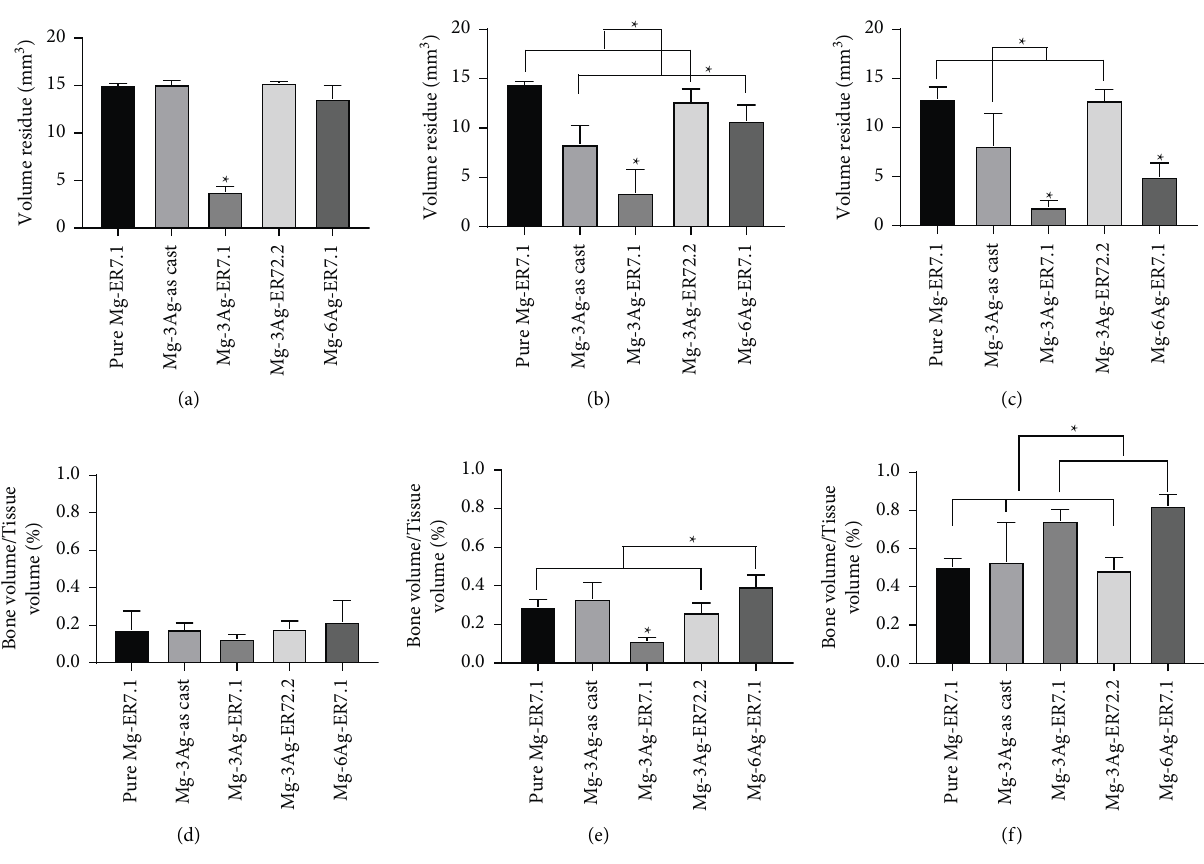
Figure 12: Implant volume residue after (a) 1, (b) 3, and (c) 6 months of operation. Bone volume/tissue volume (BV/TV) after (d) 1, (e) 3, and (f) 6 months of operation ( ∗ p < 0 .